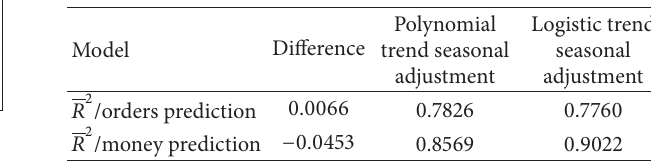
Table 6: Measure of goodness-of-fit of polynomial and logistic trend